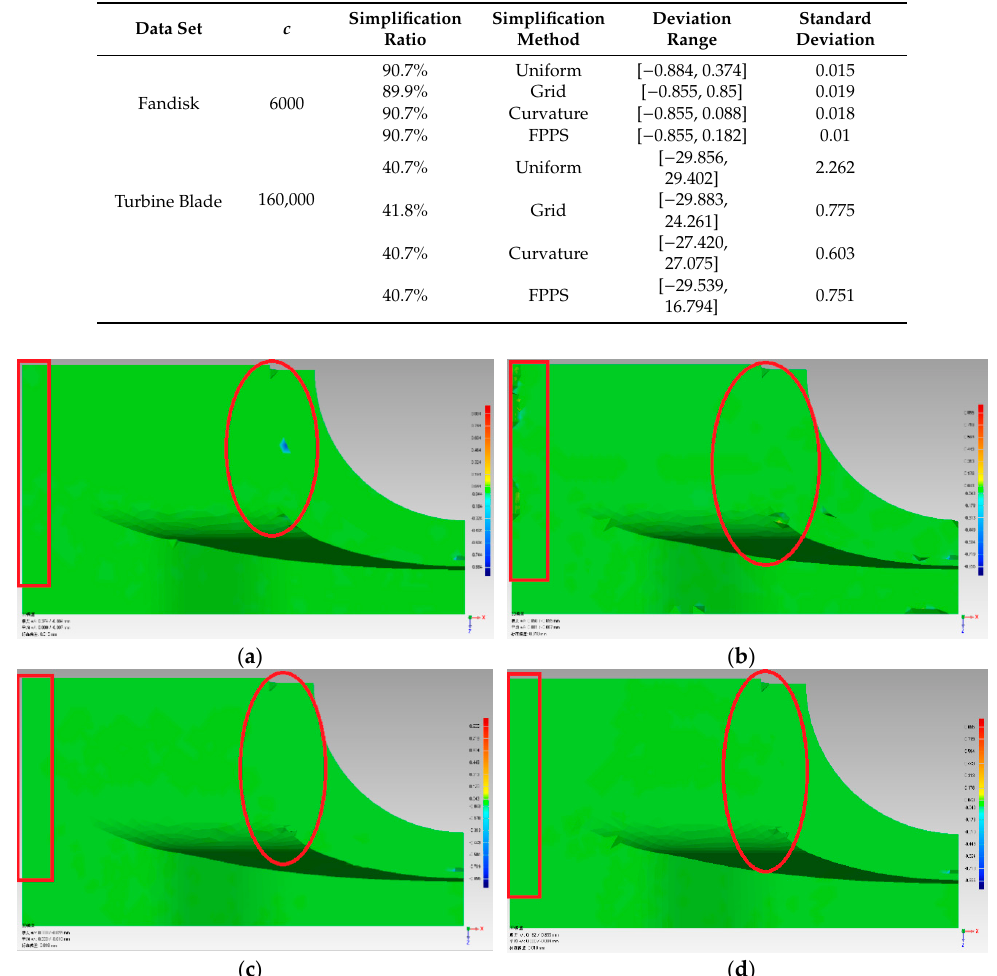
Table 4. The experiment parameters and simplification results for the Fandisk and Turbine Blade data sets.